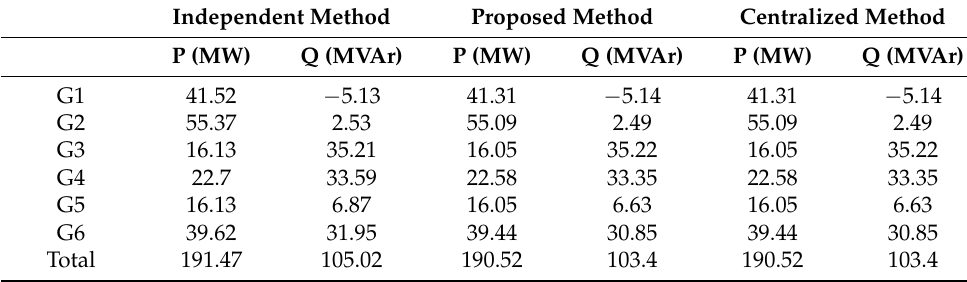
Table 5. Power output of generators in TSO with different methods on test case 1.